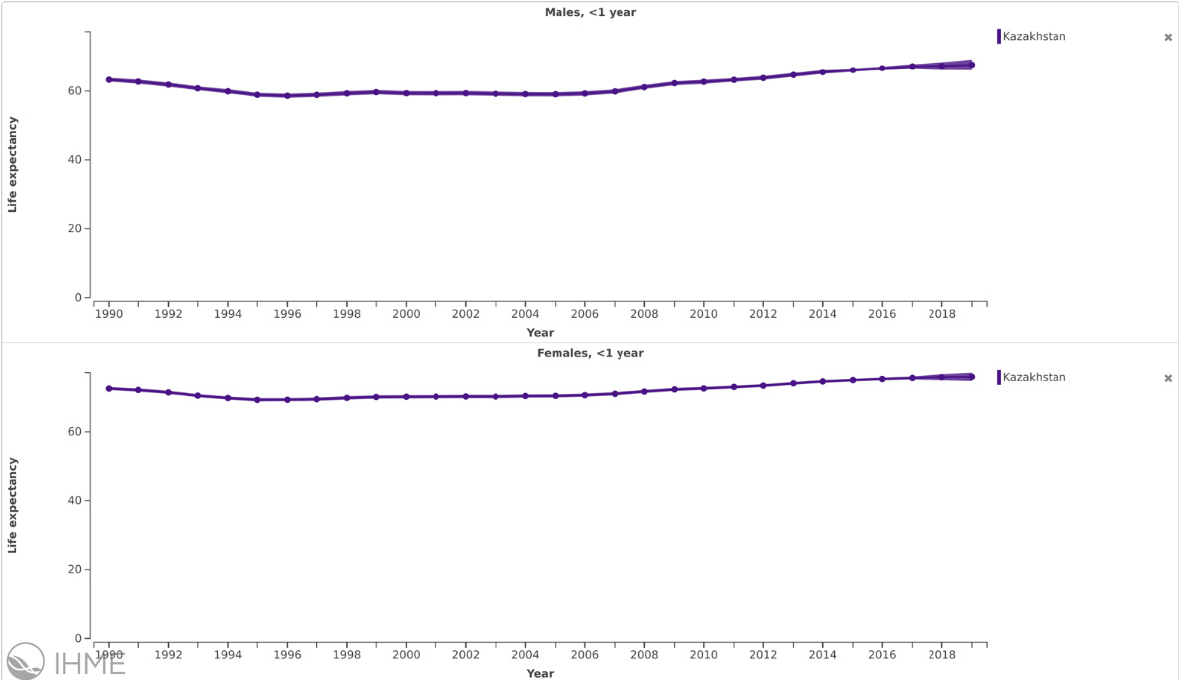
Figure 1. Life expectancy at birth, by gender, 1990 to 2019, Kazakhstan. Source: Institute for Health Metrics and Evaluation. https://vizhub.healthdata.org/gbd-compare/ (accessed on 22 November 2021).